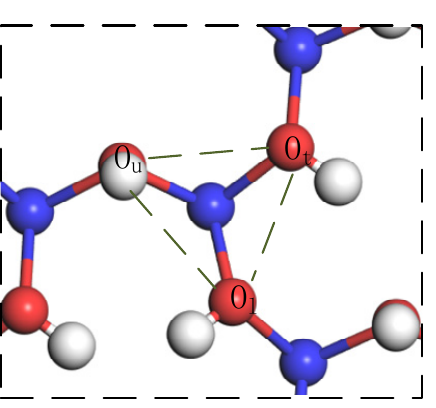
Figure 2. Picture of the sites of hydrate Fe(OH) 2+ inner ‐ layer adsorption on Al ‐ OH surface. In the above formula, E Fe / S , E Fe and E S represent the total energy of the adsorption complex formed after adsorption of the adsorbent on the kaolinite surface, and the energy of the adsorbent and kaolinite surface before adsorption, respectively. The lower the value of E ads in the calculation results, the more stable the adsorption complex